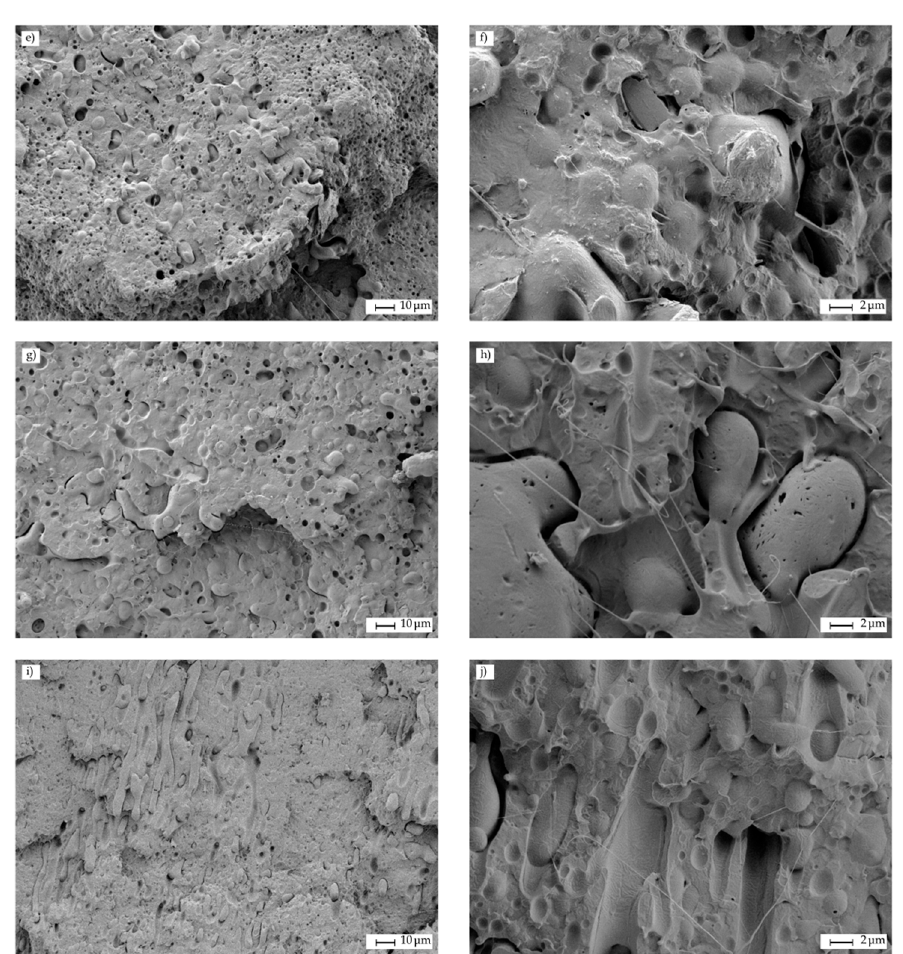
Figure 1. Field emission scanning electron microscopy (FESEM) images of the fractured samples from impact tests corresponding to the PLA 60 /PHB 10 /PCL 30 blend with different compatibilizers at 500 × (left) and 3000 × (right). ( a , b ) uncompatibilized; ( c , d ) compatibilized with 5 phr ESO; ( e , f ) compatibilized with 5 phr AESO; ( g , h ) compatibilized with 5 phr MSO; ( i , j ) compatibilized with 1 phr epoxy styrene-acrylic oligomer (ESAO).